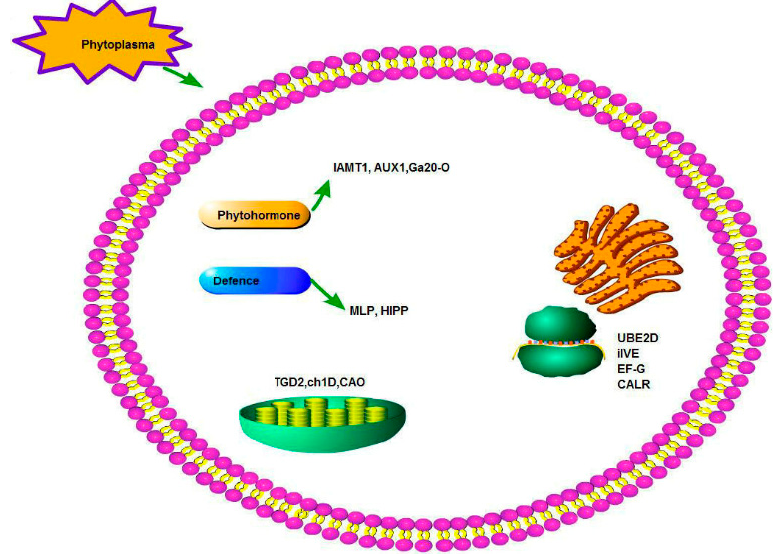
Figure 5. A hypothetical model for PaWB.